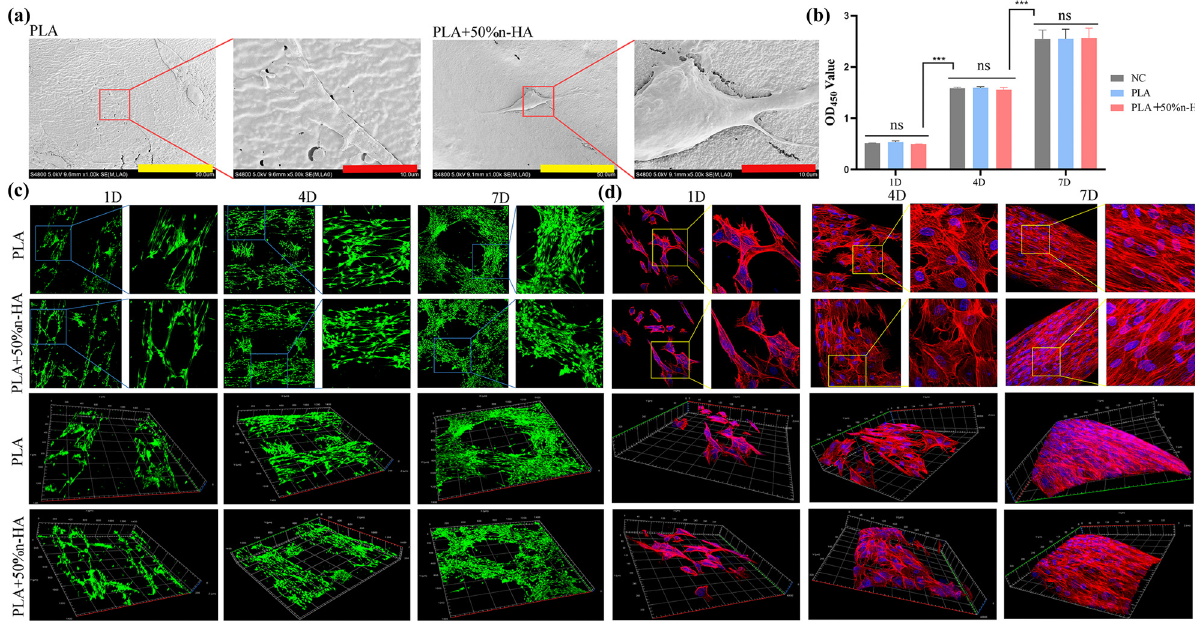
Figure 6: Biocompatibility of 3D - printed sca ff olds. ( a ) 3D printing PLA and PLA/n - HA sca ff olds loaded with BMSCs under SEM ( bar, low power = 50 μ m; high power = 10 μ m ) ; ( b ) cell activity and cytotoxicity tests of BMSCs on PLA and PLA/n - HA sca ff olds for 1, 4, and 7 days; ( c ) live/dead cell staining of BMSCs on 3D printing PLA and PLA/n - HA sca ff olds for 1, 4, and 7 days; and ( d ) cytoskeleton F - actin - stained BMSCs on sca ff olds on day 1, 4, and 7. *** p <